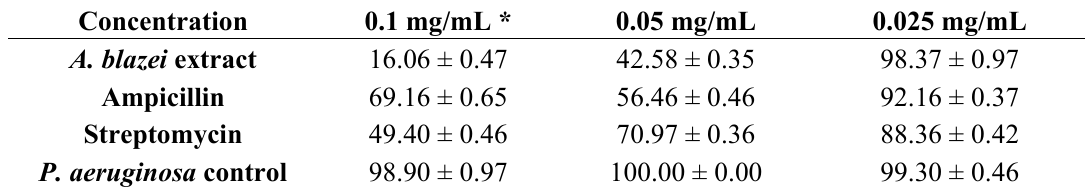
Table 1. Effects of Agaricus blazei water extract on biofilm formation of Pseudomonas aeruginosa (PAO1). Mean ± SD diameters of the growth clear inhibition zones around the discs in millimeters.